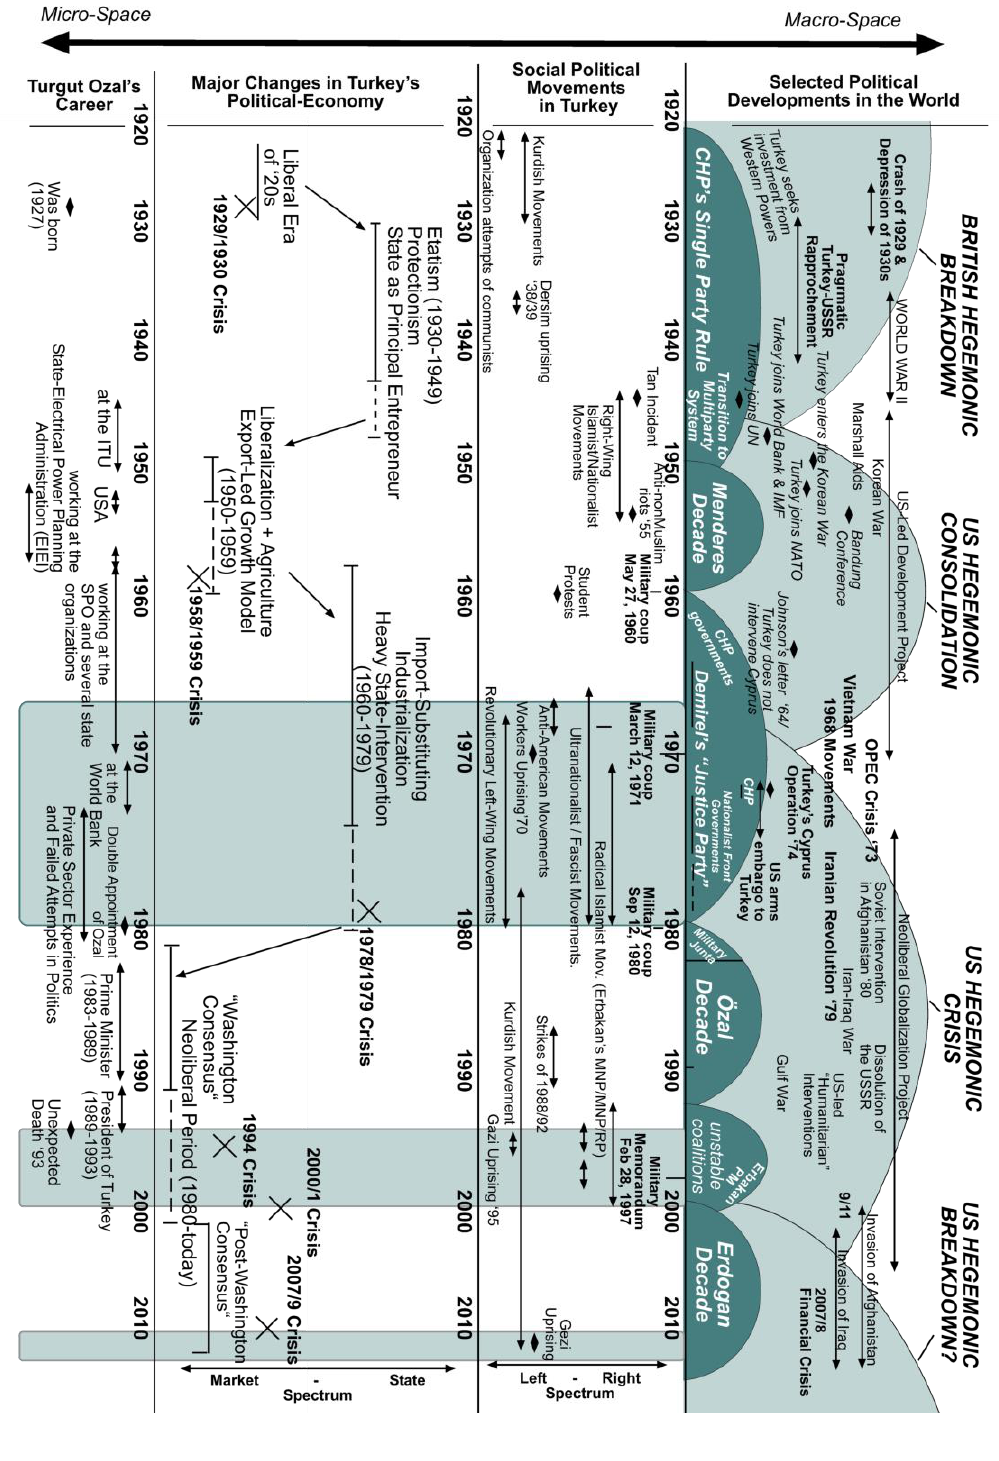
Figure 1: World-Systemic Transformations, Political Economy and Social Movements in Turkey, and Key Events Related to Özal's Career